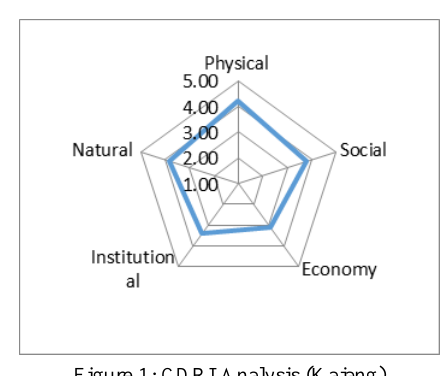
Figure 1: CDRI Analysis (Kajang)